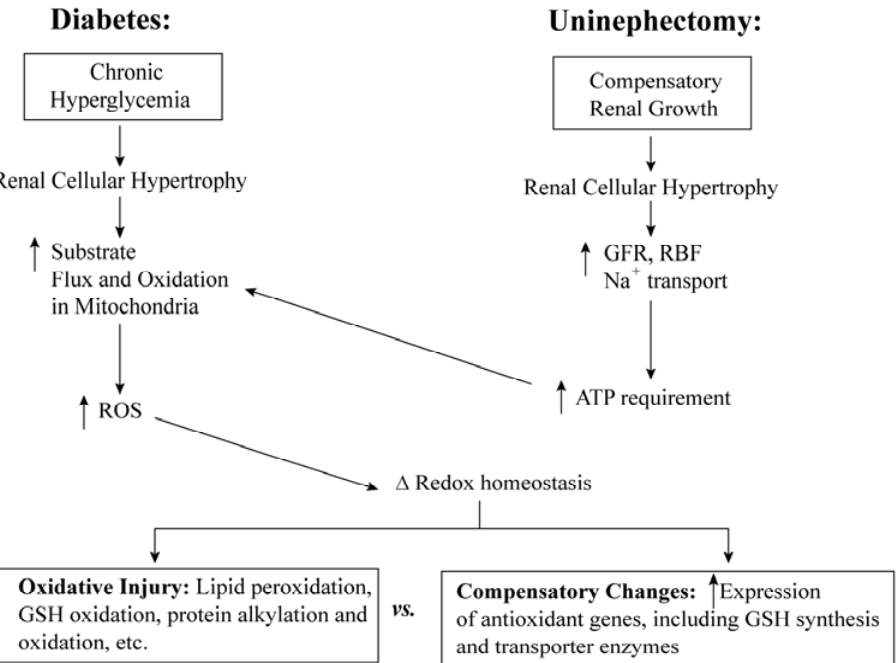
Figure 4. Scheme of functional and biochemical responses to diabetes or uninephrectomy that are associated with changes in mitochondrial redox status. Abbreviations: GFR, glomerular filtration rate; GSH, glutathione; RBF, renal blood flow; ROS, reactive oxygen species. The scheme is based on one published in reference [25] with some